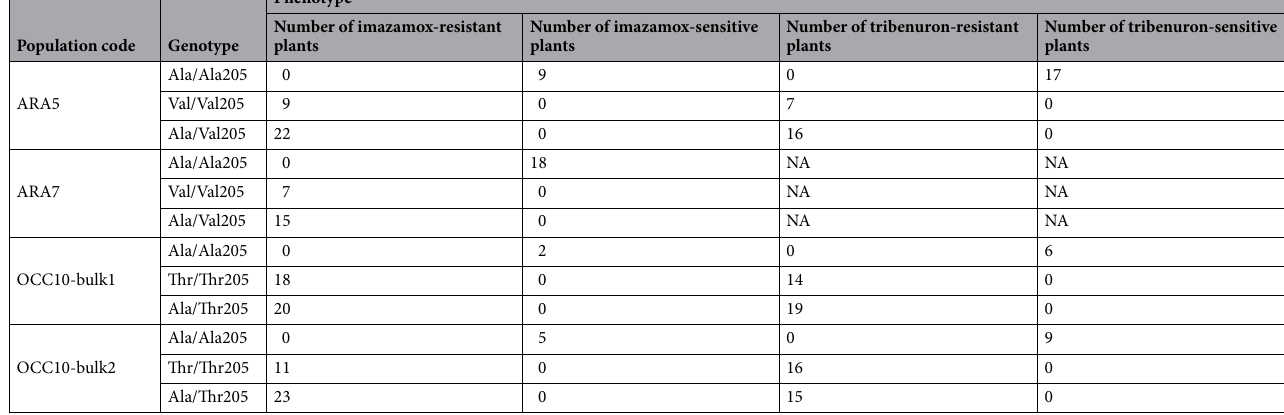
Table 3. Genotype at ALS codon 205 and sensitivity to imazamox or tribenuron of common ragweed. Forty plants were assayed per population and per herbicide. NA not